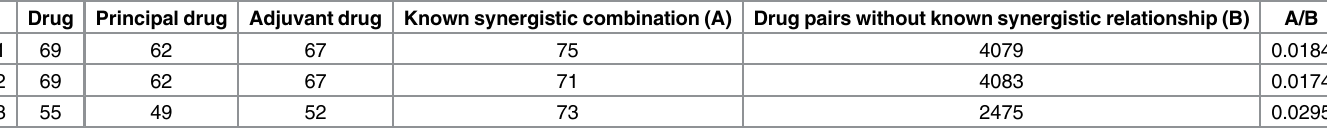
Table 1. Statistics of three drug combination datasets were listed, including the number of drugs, principal drugs, adjuvant drugs, known syner- gistic combinations (A), and drug pairs without known synergistic relationship (B) and the ratio A/B. Drug Principal drug Adjuvant drug Known synergistic combination (A) Drug pairs without known synergistic relationship